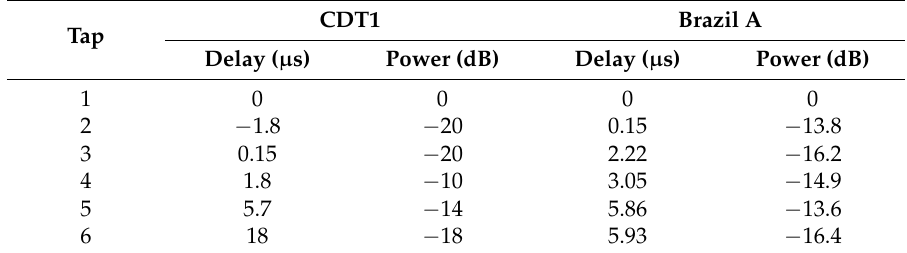
Table 1. Profiles for the China digital television (DTV) Test 1st (CDT1) and Brazil A multipath fading channels.